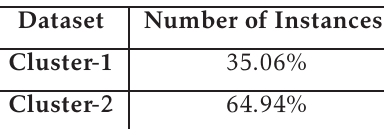
Table 4. Regular Clustering